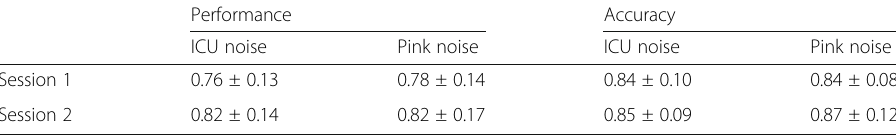
Table 2 Working memory task performance and accuracy per noise condition and sessions. The values represented are mean ± standard